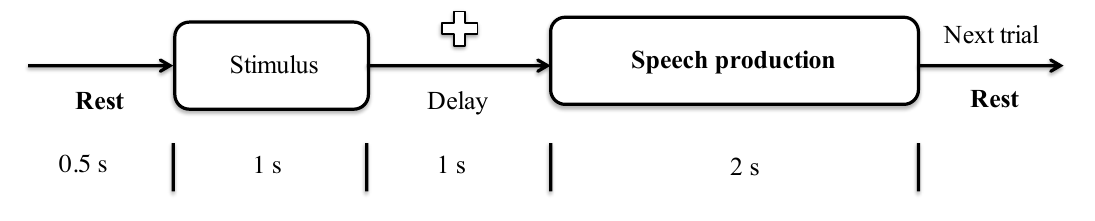
Figure 2. Time-locked